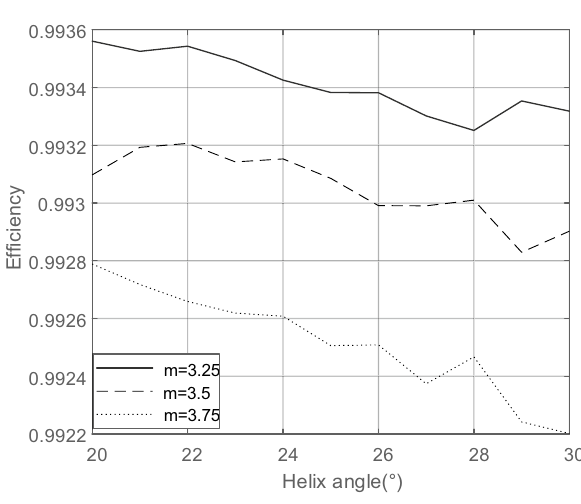
Fig. 20 Efficiency of different modulus and helix angle at equal bending strength of the teeth and pressure angle of 22.5°